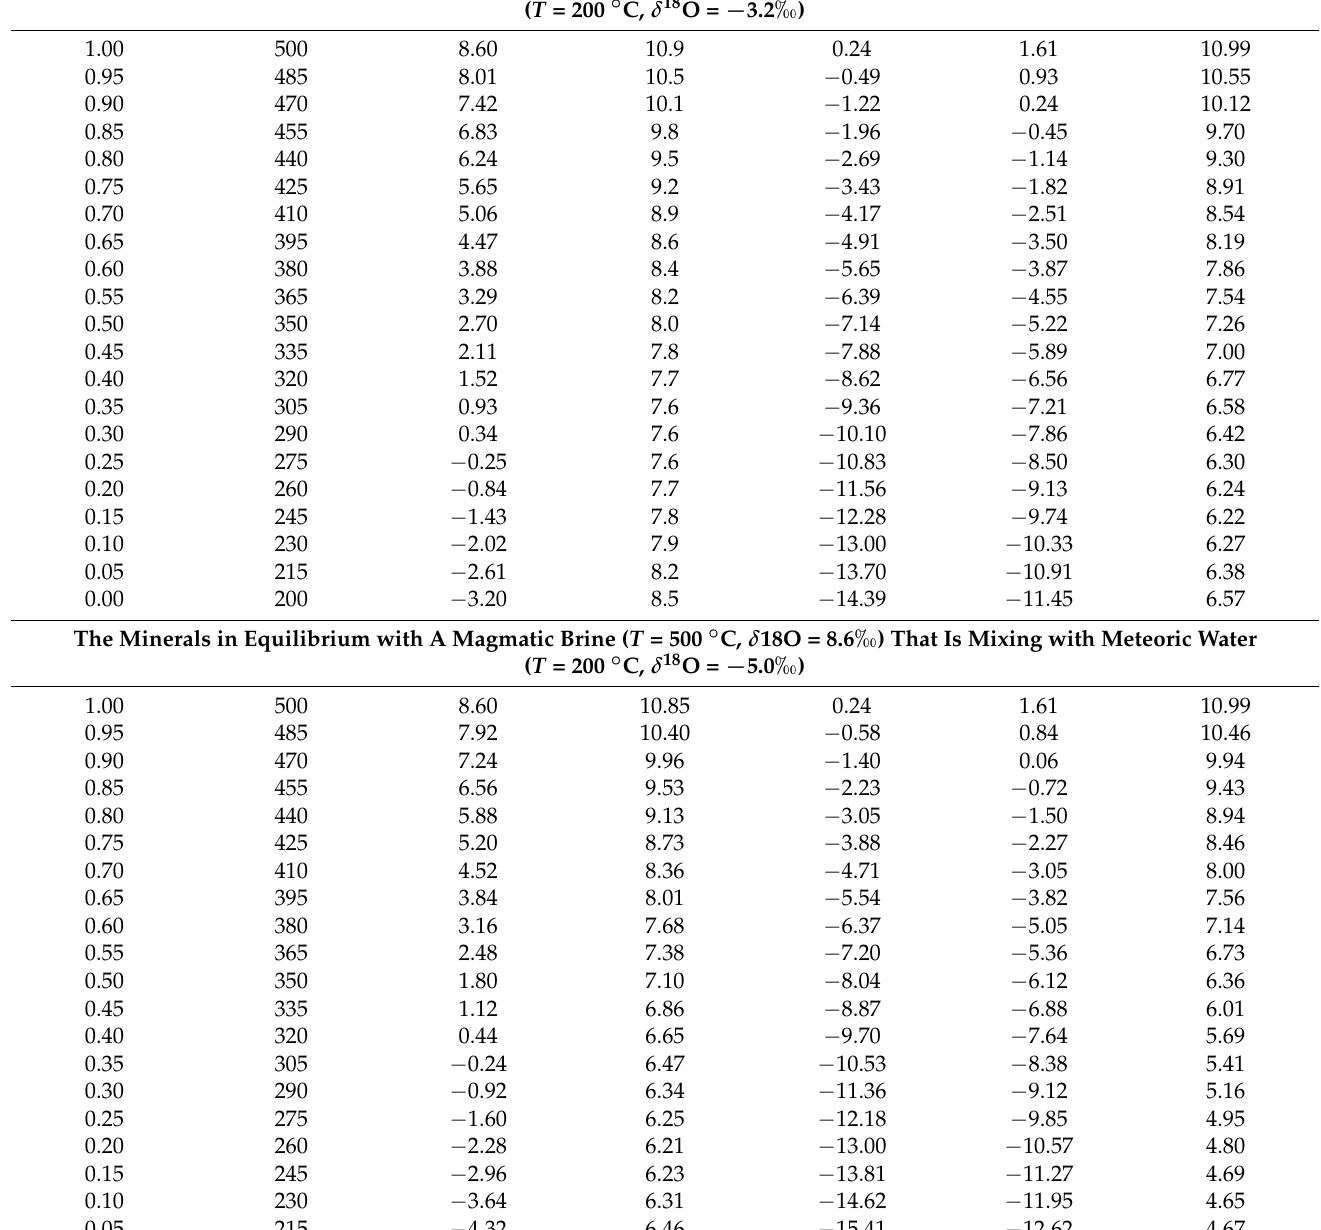
Table 2. Calculated oxygen isotope compositions of quartz, hematite, magnetite, and calcite in the mixing model. F = Mass T mix ( ◦ C) δ 18 O water Fraction Brine Quartz Hematite Magnetite Calcite The Minerals in Equilibrium with A Magmatic Brine ( T = 500 ◦ C, δ 18 O = 8.6